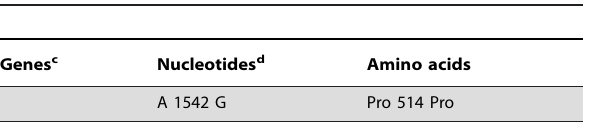
Table 1. Polymorphisms in L. tropica isolates a,b . Table 1.